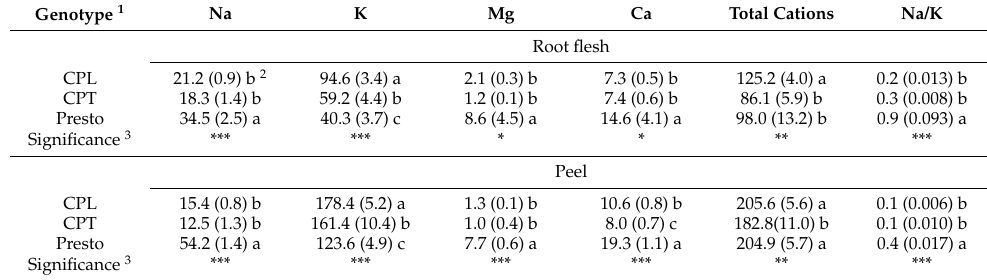
Table 2. Concentration of cations in the root flesh and peel of carrot genotypes (mg 100 g − 1